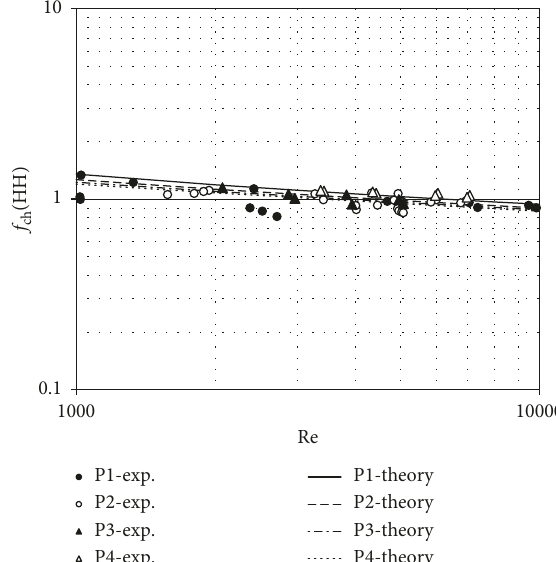
Figure 9: Fanning friction factor f corrugated field.